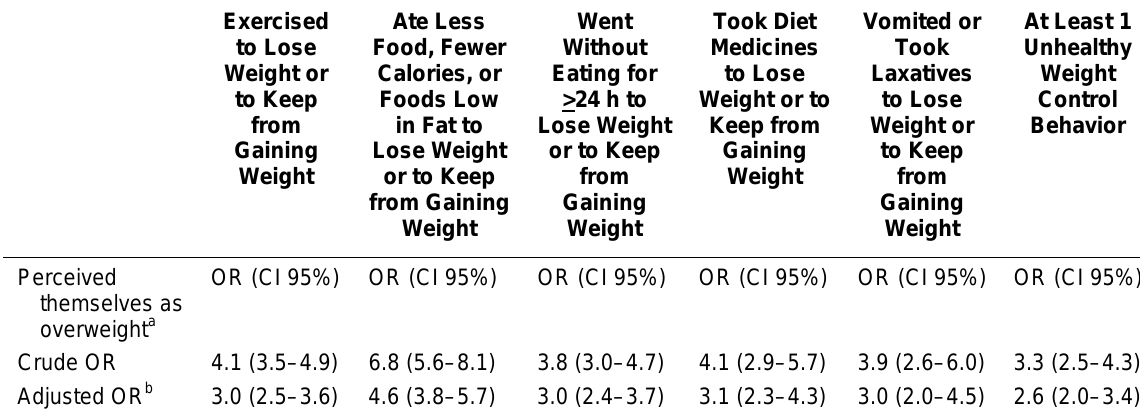
Odds Ratios of Overweight Perception and Weight Control Behaviors of U.S. Normal